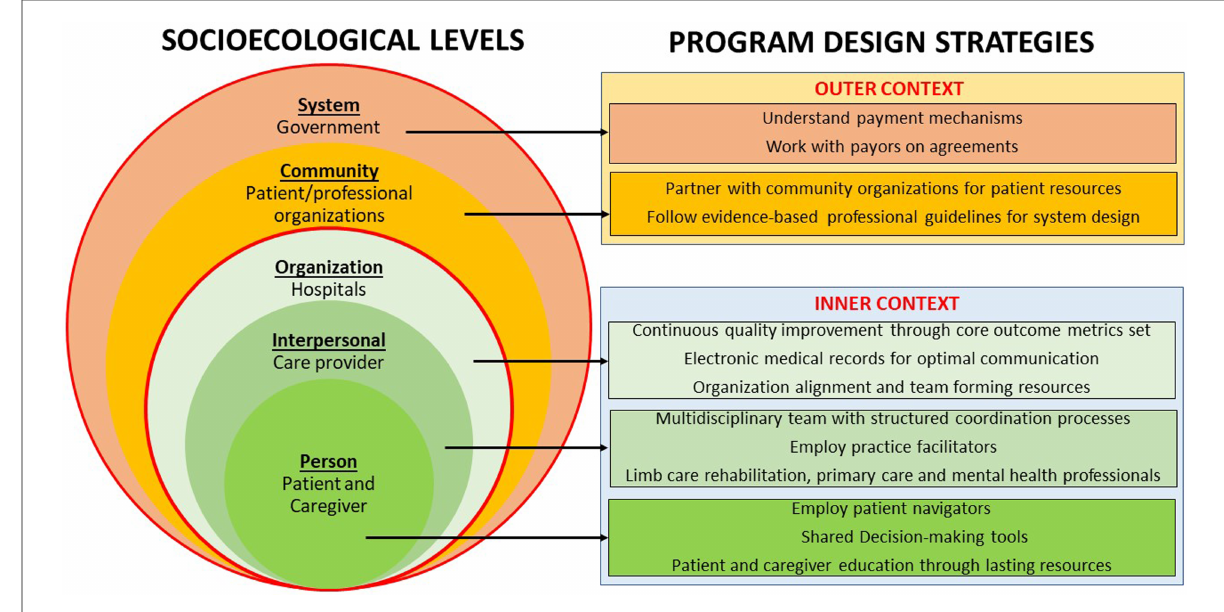
FIGURE 2 Socioecological level-based limb preservation program (LPP) design strategies for inner and outer